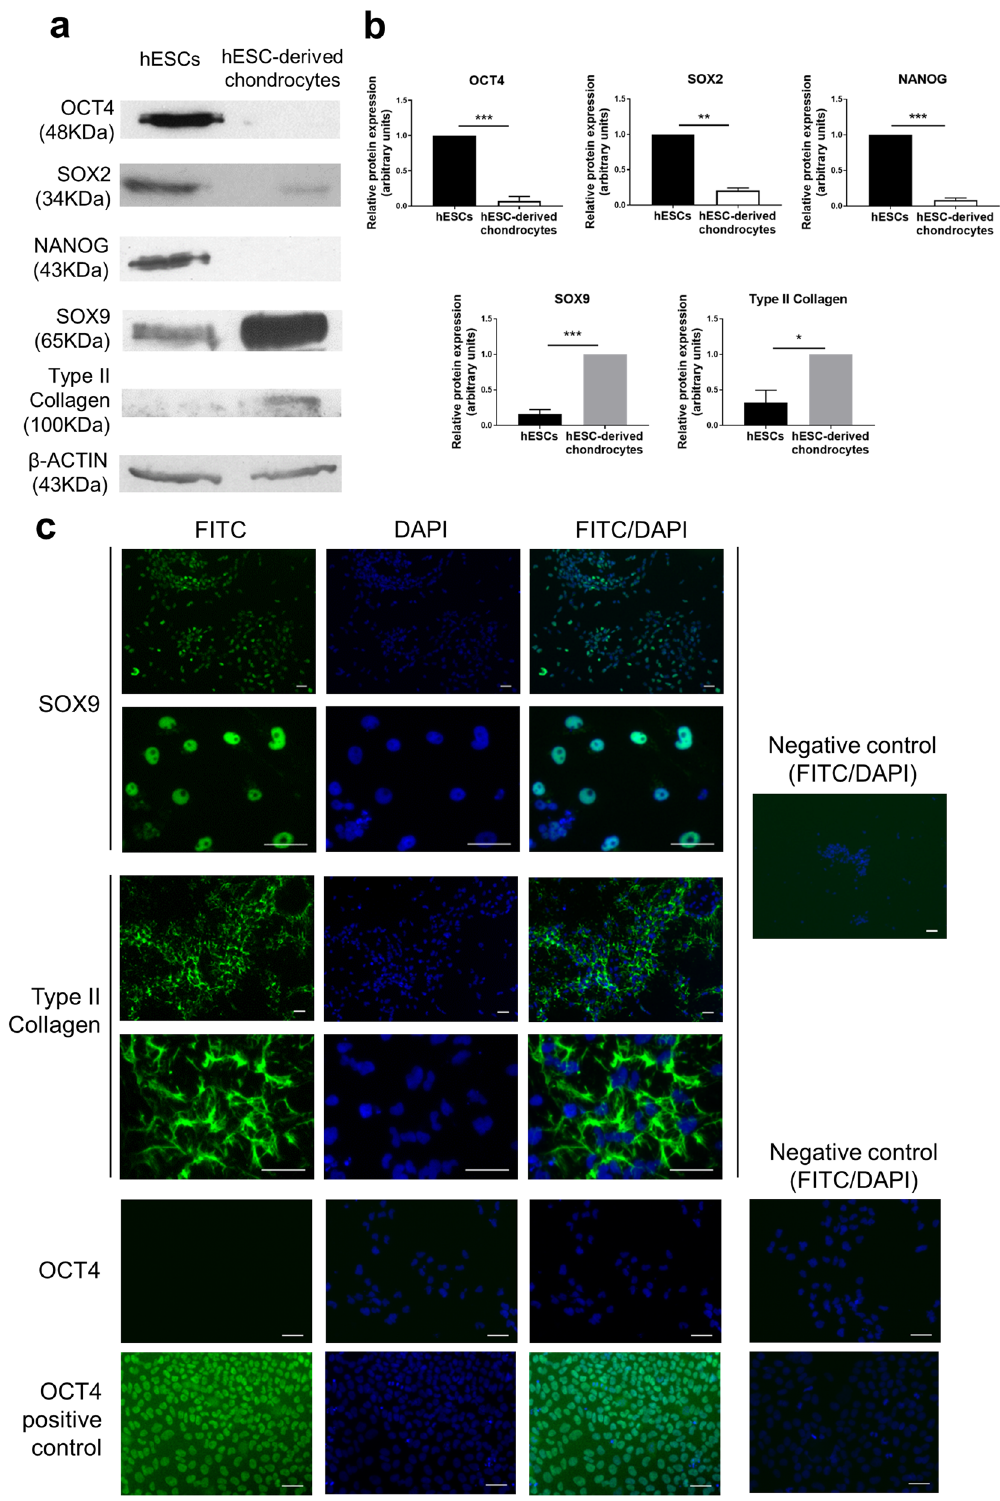
Figure 1. Differentiation of hESCs into chondrocytes. Representative Western blots ( a ) and quantification of the blots ( b ) showing a loss of pluripotency markers OCT4, SOX2 and NANOG and a gain of chondrocyte markers SOX9 and Type II Collagen in hESC-derived chondrocytes compared to hESCs. Data were normalised to β-actin and to 1 for either hESCs (OCT4, SOX2 and NANOG) or hESC-derived chrondrocytes (SOX9 and Type II collagen). Graph shows mean ± SEM. n = 3–5 biological replicates, * p < 0.05, ** p < 0.01, *** p < 0.001. Immunocytochemistry ( c ) showing expression of SOX9 in hESC-derived chondrocytes and Type II collagen in the extracellular matrix and a lack of OCT4 expression. The positive control shows OCT4 expressing hESCs. The negative controls represent omission of the primary antibody. Scale bars 50